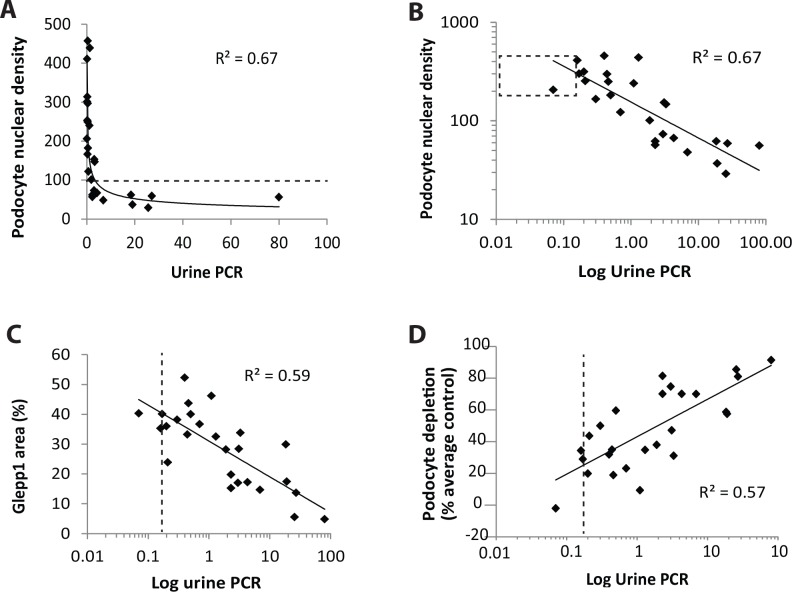
Proteinuria increases in proportion to podocyte number per glomerular tuft and podocyte density decrease.Panel A: Urine PCR shown on a linear scale in relation to podocyte density demonstrating that as podocyte density decreases below approximately 100 per 106 um3 the level of proteinuria exponentially increases. Panel B: The same data as shown in Panel A except that proteinuria and podocyte density are shown on a log scale. The dotted box represents the mean±1SD for podocyte density and the upper limit of normal urine PCR at 0.18. Note that the log scale shows that proteinuria increases in proportion to reduction in podocyte density over a wide range. Panel C: Glepp1% area is an alternative way of measuring podocyte density also shows an exponential (log) relationship with proteinuria. Panel D: % podocyte depletion (calculated as a % of the normal age-matched mean level for each sample) shown in relation to log urine PCR demonstrating that at the upper limit of normal urine PCR (0.18) occurs when approximately 20% of podocytes have been lost. By the time the urine PCR has reached a value of 1 about 40% of podocytes have been lost. These data illustrate that low level proteinuria is a moderately early marker of podocyte depletion in ASC biopsies.